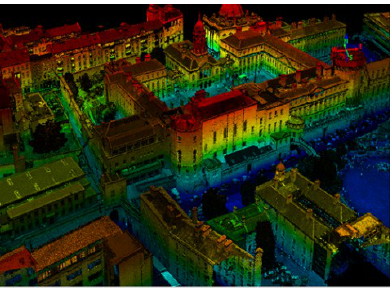
Figure 13: Sample of Aerial Laser and Photogrammetry Survey of Dublin Historic City